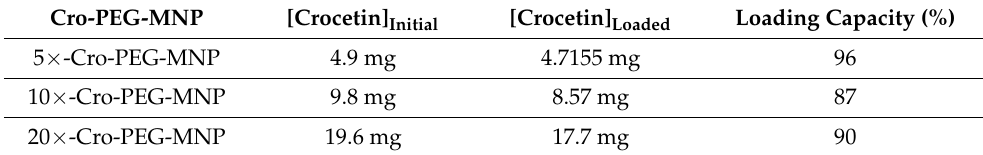
Table 1. Loading capacity of crocetin-functionalized PEG-MNPs via waste